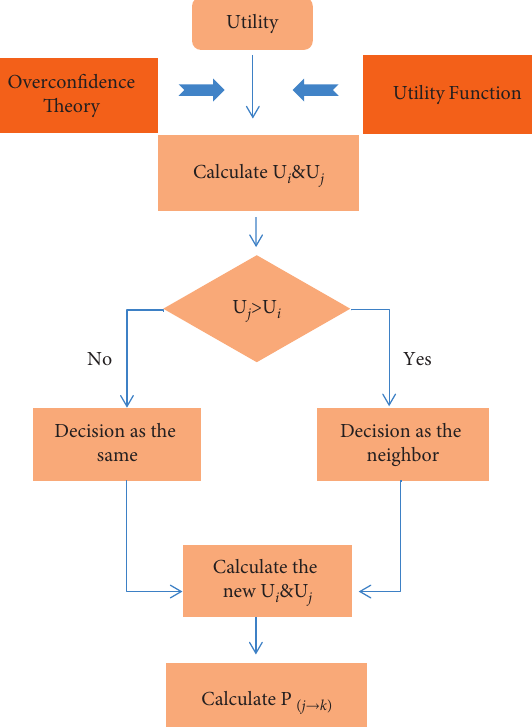
Figure 3: Flow chart of individual learning